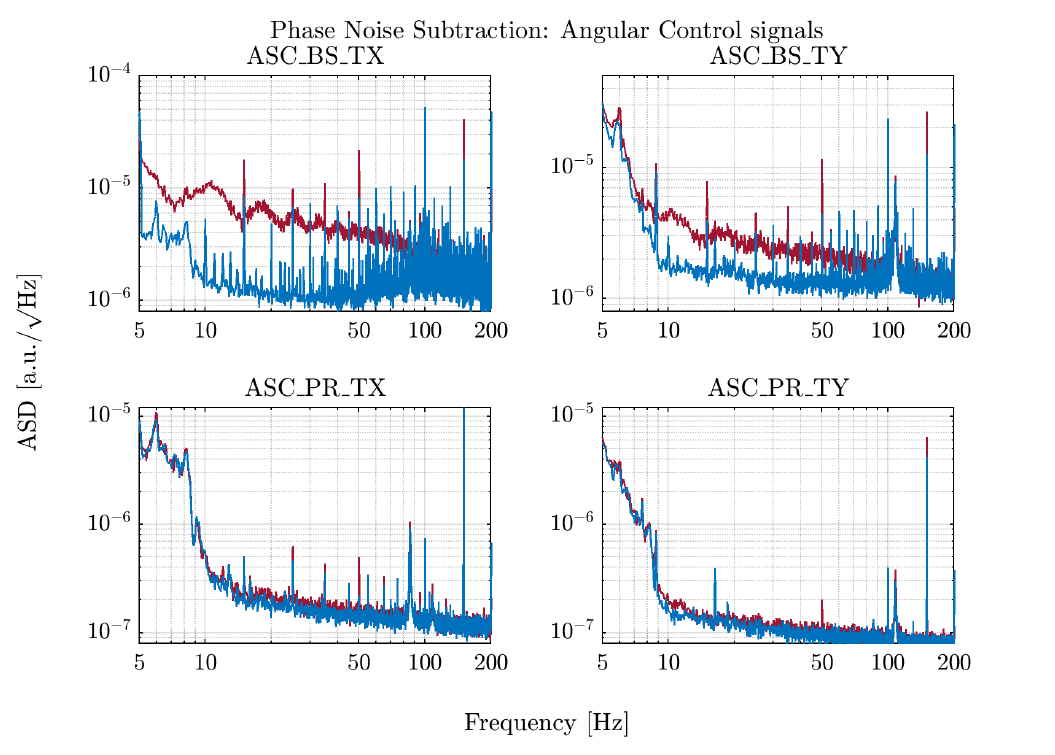
Figure 10. Angular error signals for the BS and PR mirror control, before (in red) and after (in blue) the implementation of the phase noise